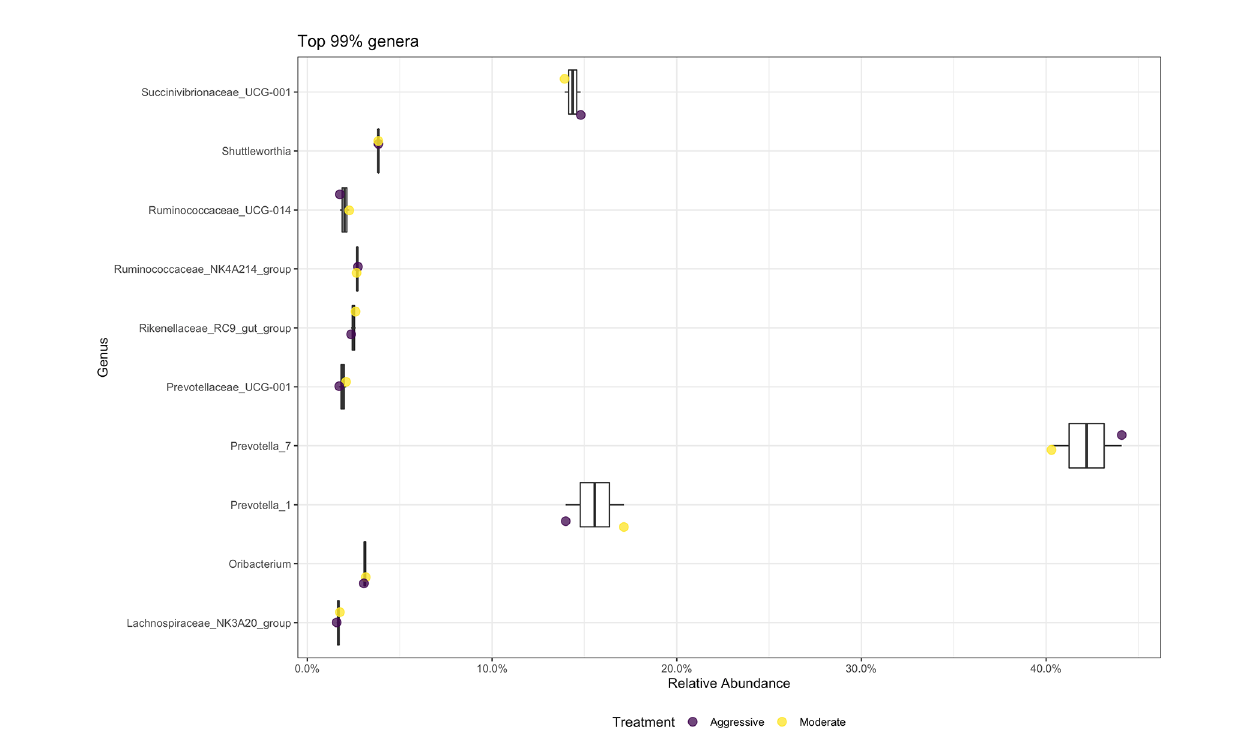
FIGURE 4 | Average relative abundance of the top 99% genus-level bacterial communities classi fi ed in ruminal fl uid between aggressive or moderate implant strategies. Mean relative abundance of bacterial communities associated with the aggressive implant strategy are represented in purple and moderate implant strategy in yellow. Relative abundance was calculated by reads of taxon/total reads in a sample to compare between